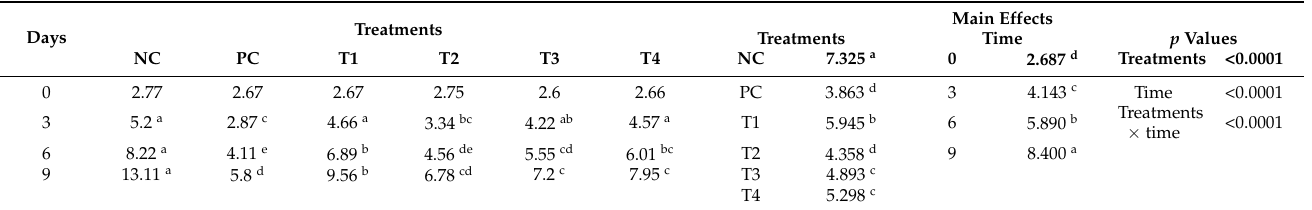
Table 7. Changes in total viable count of minced pork depending on treatment and storage